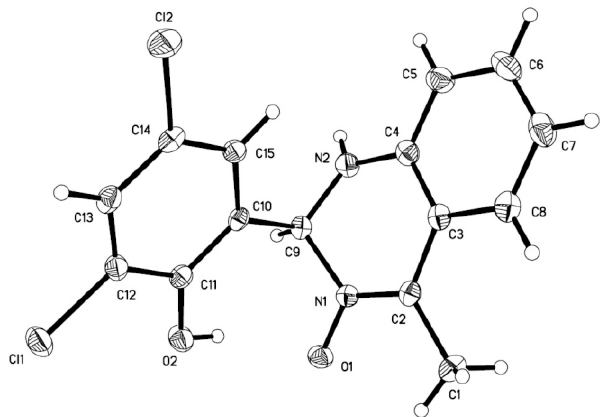
Table 1. Data collection and handling.